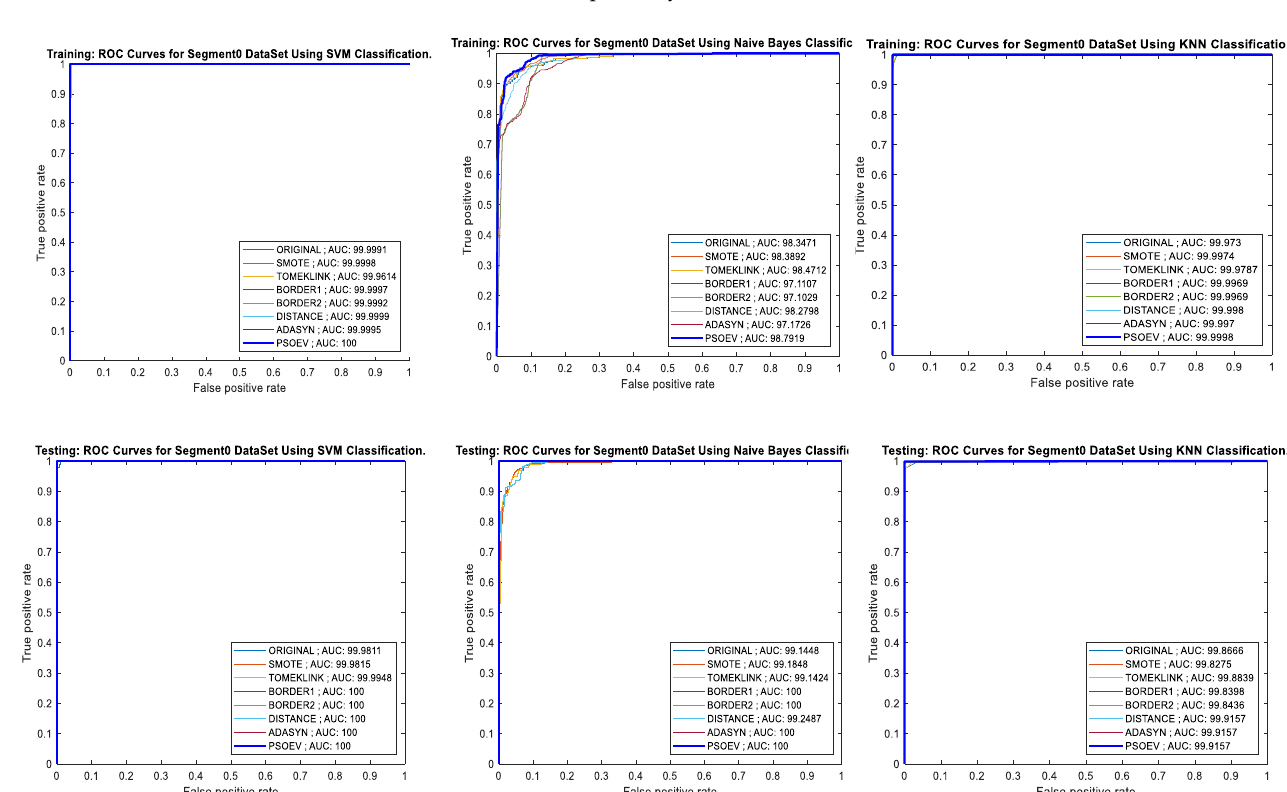
Figure 10. AUC-ROC curves of training and testing of Ecoli1 dataset using SVM, NB, and k -NN classification methods, respectively.